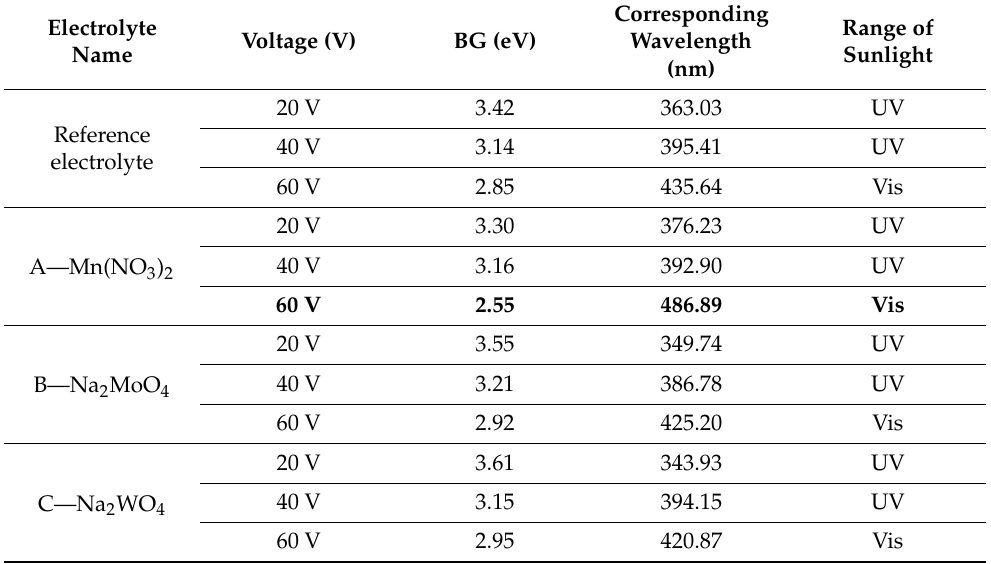
Table 5. Bandgap (eV) of anodic oxide prepared in reference and modified electrolytes with corre- sponding wavelength (nm) and region of